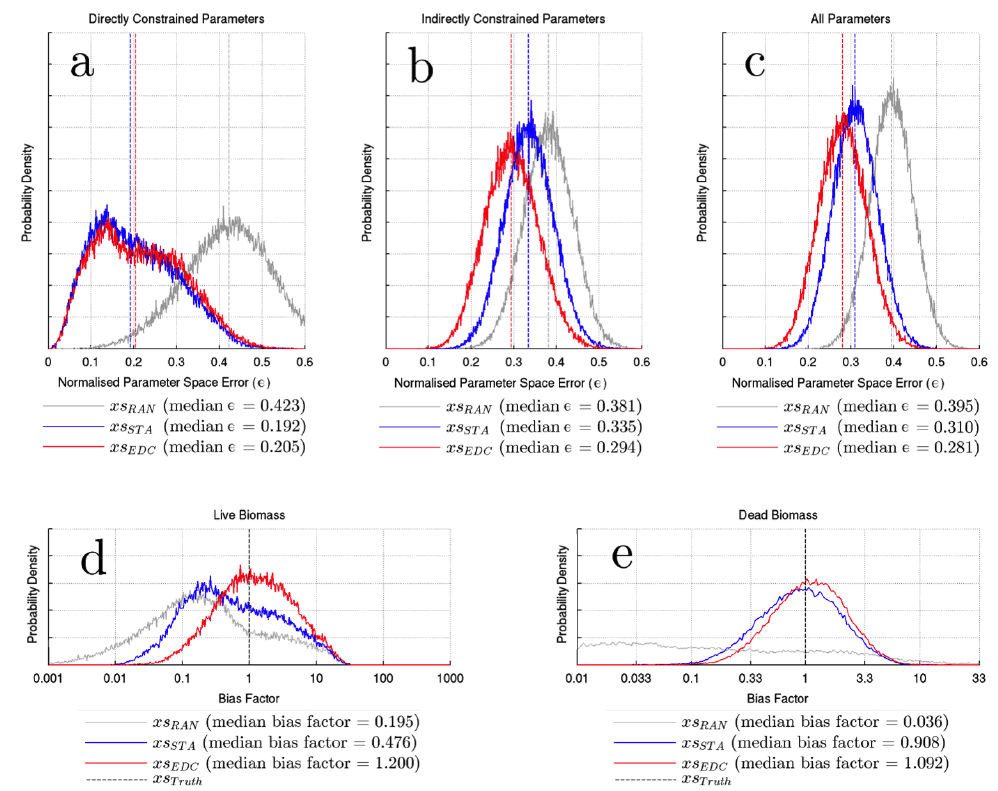
Figure 2. Aggregated parameter estimates xs STA (standard sampling, blue) and xs EDC (EDC sampling, red) from deciduous and evergreen synthetic LAI and soil organic carbon observations – these are compared against observation and EDC independent parameter samples xs RAN (light grey). Normalized parameter space error ( (cid:15) ) probability density functions for (a) Group A (directly inferable) parameters, (b) Group B (indirectly inferable) parameters and (c) all DALEC2 parameters. (cid:15) values for each parameter group were derived using Eq. (15). In panels (d) and (e) the probability density functions of live biomass (foliar, labile, wood and roots) and dead biomass (litter and soil carbon) biases against the synthetic truth parameters s are shown for xs RAN , xs STA and xs EDC parameter